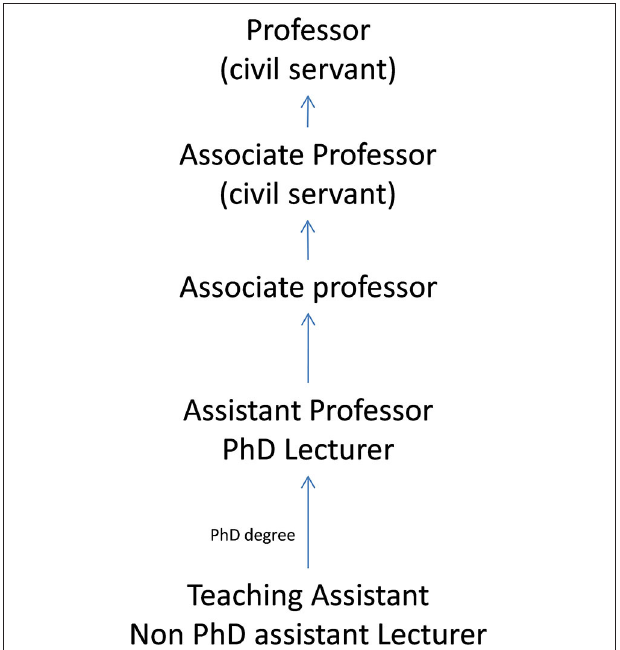
FIGURE 2 | Academic career paths in Spanish public